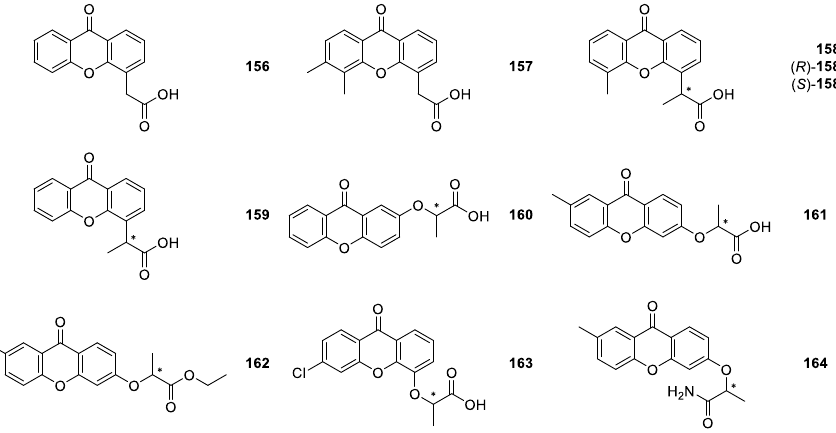
Figure 15. Structures of XAA ( 156 ), DMXAA ( 157 ) and chiral analogues 158 – 164